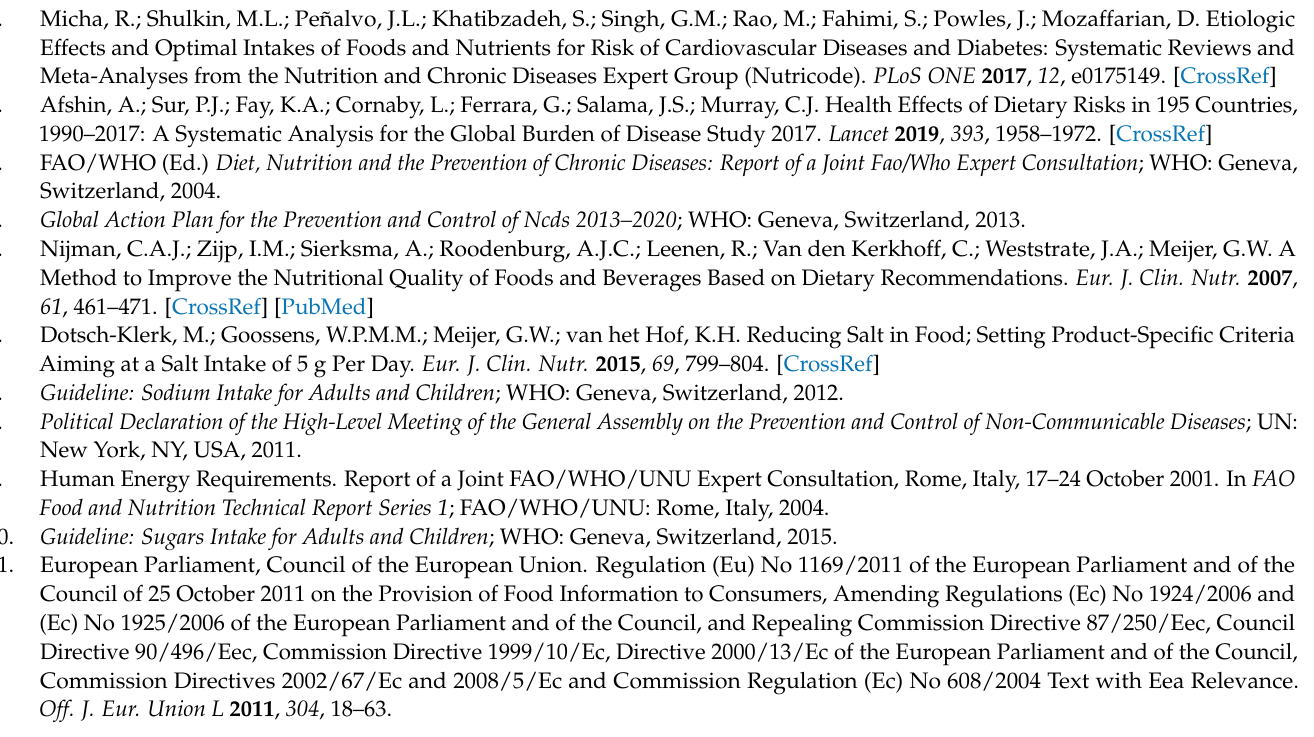
energy intake, Table S5: Top contributors to changes in sodium intake, Table S6: Top contributors to changes in SAFA intake, Table S7: Top contributors to changes in added sugar intake, Table S8: Top contributors to changes in total sugar